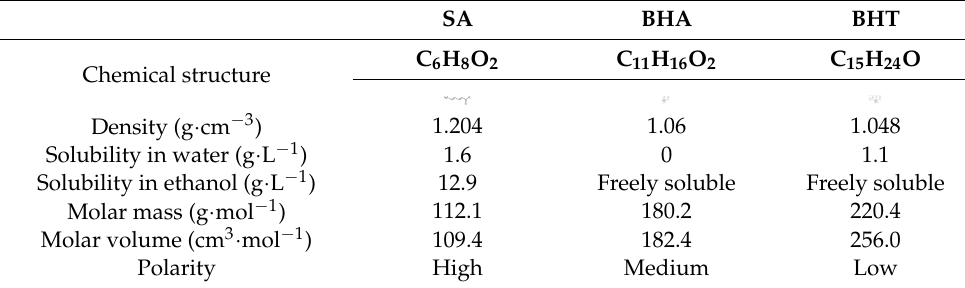
Table 2. Chemical structure and physical properties of SA, BHA and